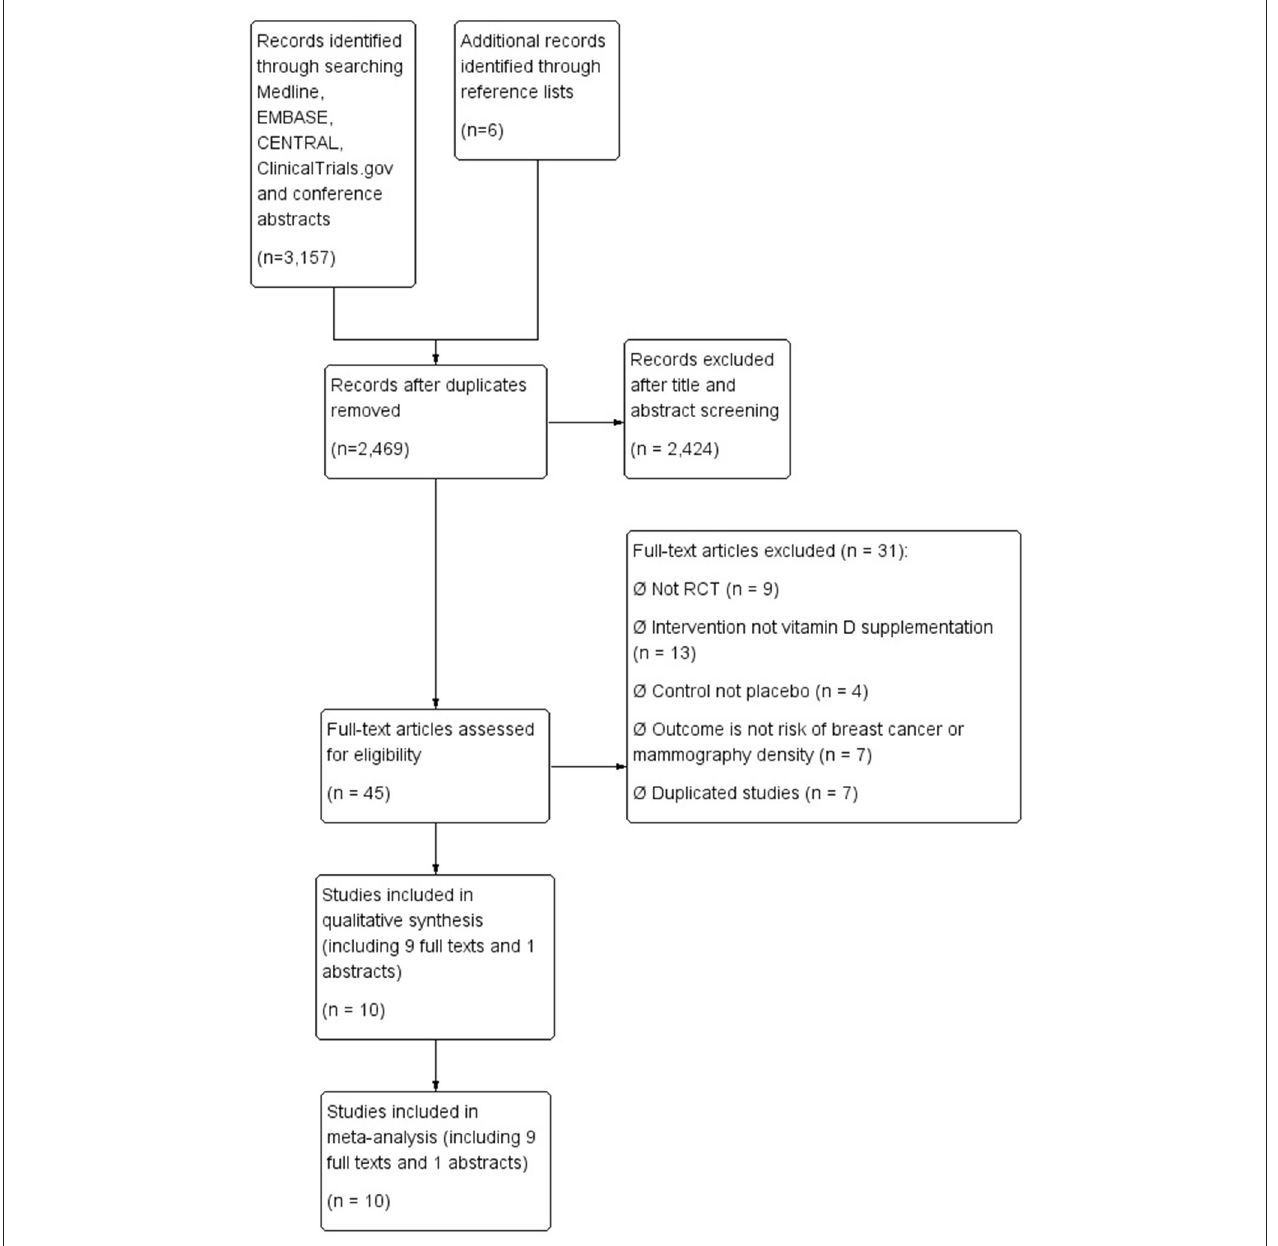
FIGURE 1 | Flow diagram for selection